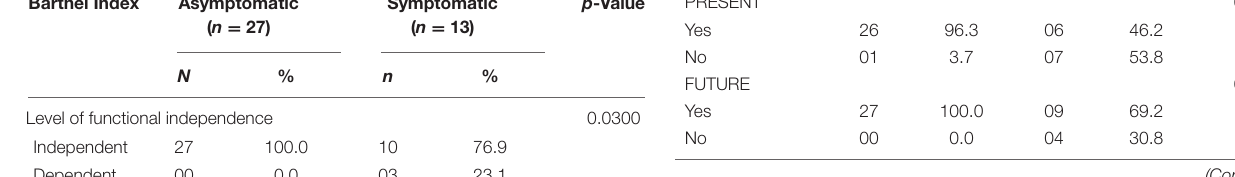
TABLE 3 | Distribution of patients based on the total Barthel Index score by group. Barthel Index